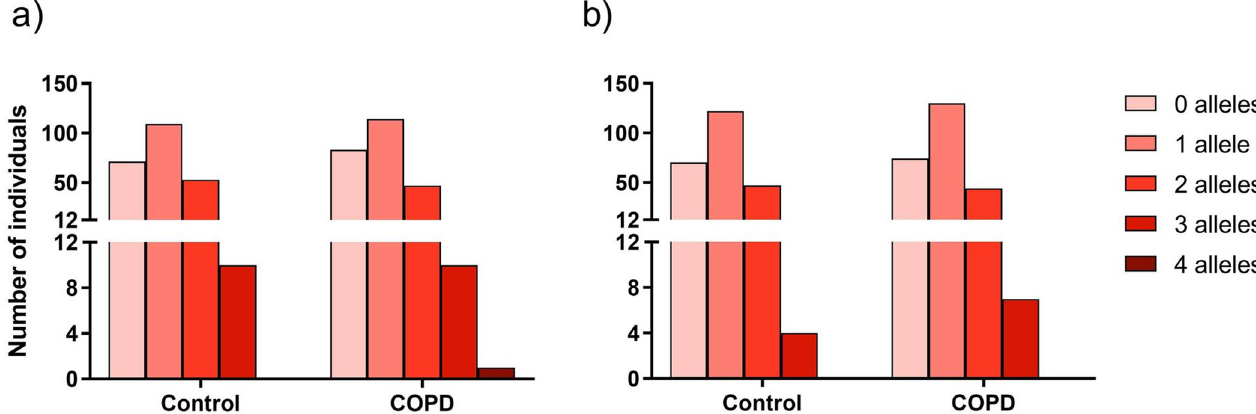
Fig 2. Number of people with a cumulative number of risk alleles for a) susceptibility for COVID-19 infection and b) severe COVID-19 with respiratory failure. 0 to 4 represents the sum of effect alleles for each COVID-19 associated phenotype. No significant differences were found, between COPD and control groups, for the distribution of people in the risk groups. a) p-value = 0.71 and b) p-value =